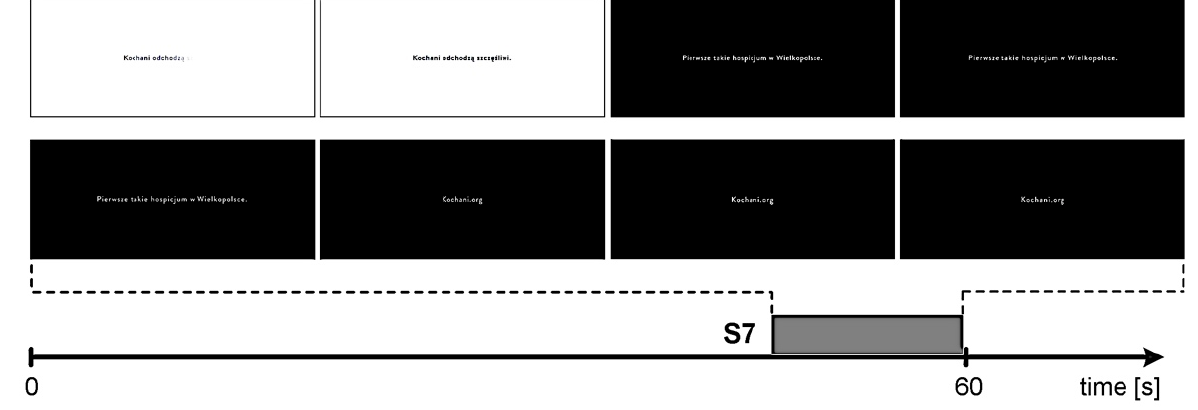
Figure 5. Frames extracted for S7 from advertisement under study.